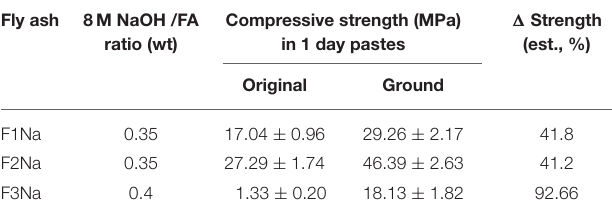
unground coal fly ash and cured for 20h at 85 ◦ C. Fly ash 8M NaOH /FA ratio